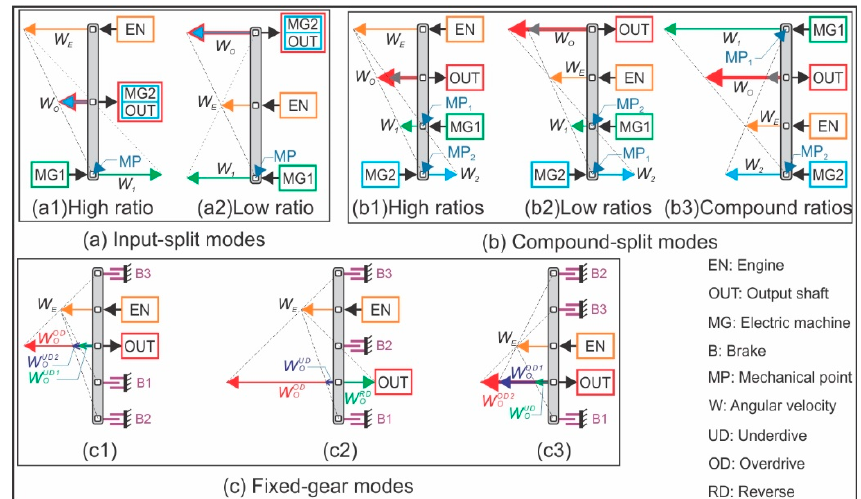
Figure 12. Lever diagrams of different operating modes.